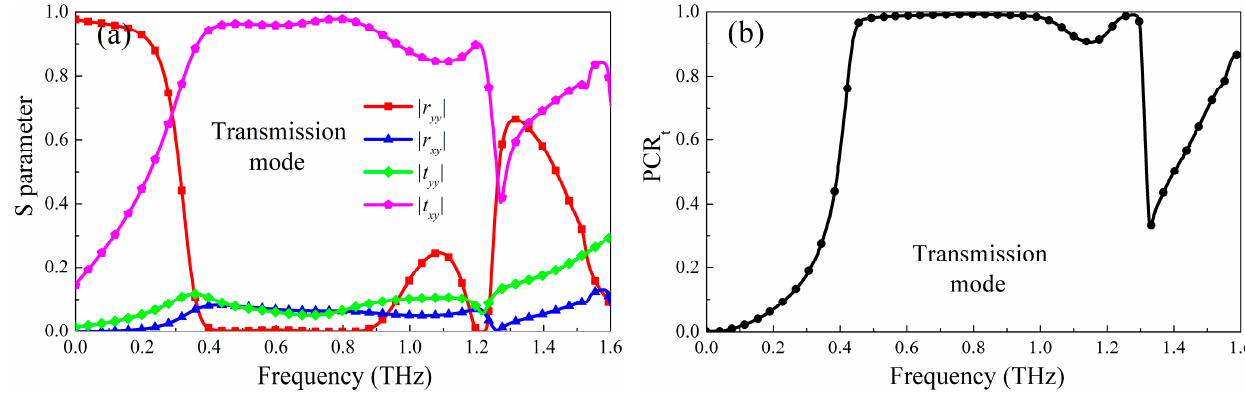
Figure 3. The Simulated results of reflection operating mode ( a ) S parameter; ( b ) PCR t .